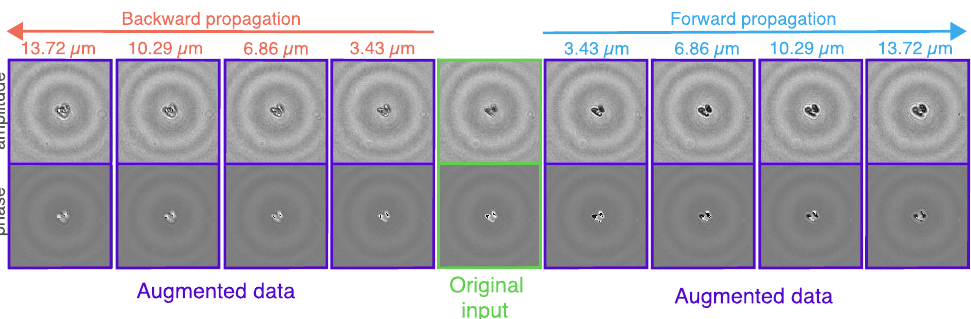
Figure 3. Examples of the application of hologram defocus augmentation for a sample in class 2-TRCs. In this illustration, from the original in-focus input hologram, we generate 8 slightly altered examples by propagating the hologram in the range of [ − 13.72, 13.72] µ m. The backward and forward propagation terms denote the direction of the propagation. Backward propagation means that we propagate in the negative direction: for example, propagating one step backward is equivalent to propagating with − 3.43 µ